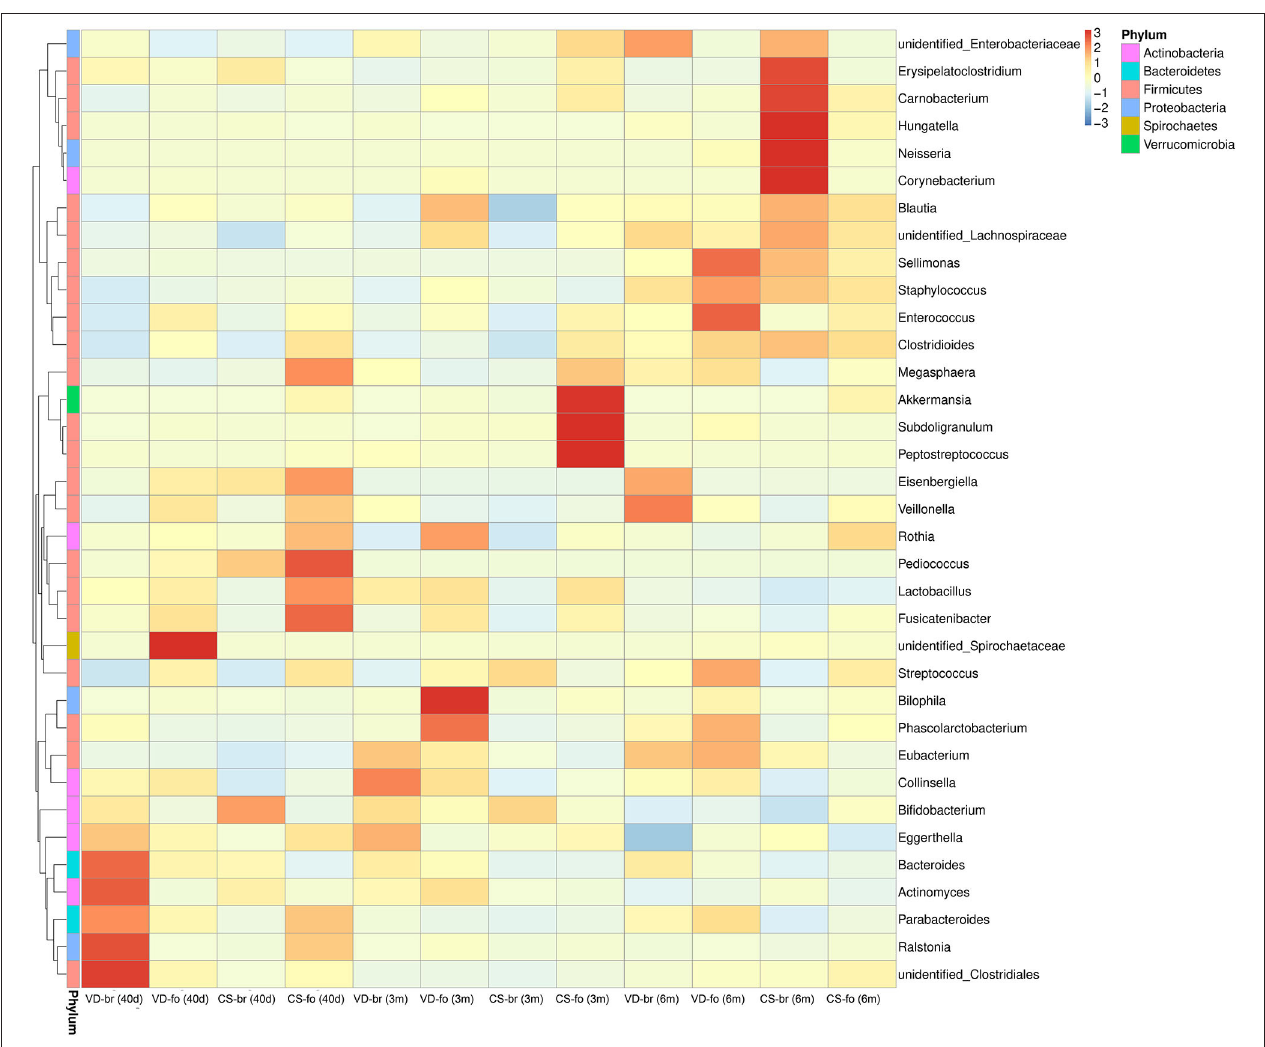
FIGURE 3 | The OTUs heatmap at genus level. The relative abundance of OTUs was assessed across all samples, and OTUs were clustered in a heatmap according to their co-occurrence at genus level. Clustering was performed as a type of hierarchical clustering method to interpret the distance matrix using average linkage. The dendrogram provides the genus designation along the right Y-axis and the abundance relationship across all samples for each genus along the left Y-axis. The color scale for the heatmap is shown in the upper right corner of the